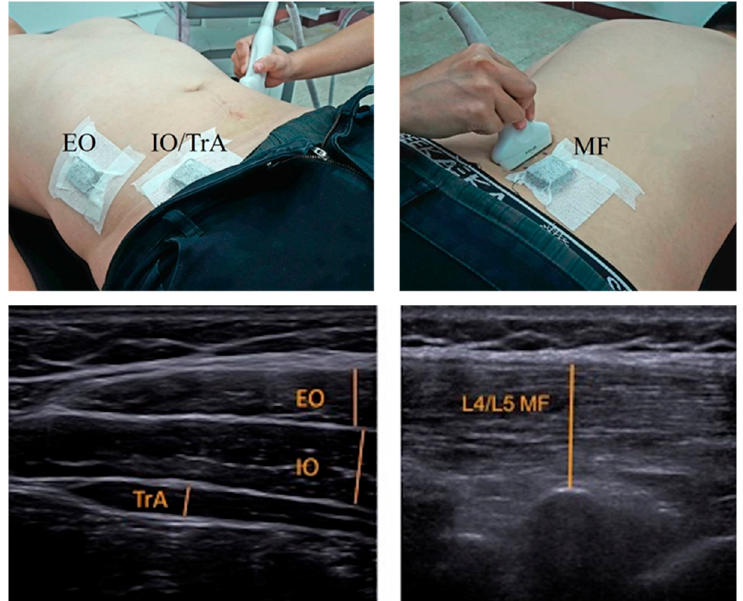
Figure 2. Positions of the ultrasound transducer and surface electromyography sensor (top) and ultrasound images of the lumbar multifidus and lateral abdominal wall muscles (bottom). EO: sound images of the lumbar multifidus and lateral abdominal wall muscles ( bottom ). EO: external external abdominal oblique; IO: internal abdominal oblique; TrA: transverse abdominis; MF: lum- bar multifidus.